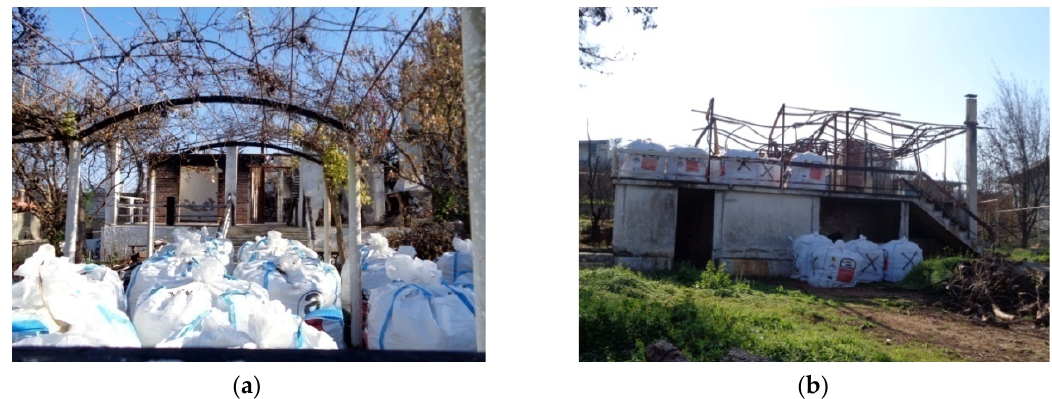
Figure 9. ( a , b ) Pictures of the remains of buildings containing asbestos, which was enclosed in special bags.